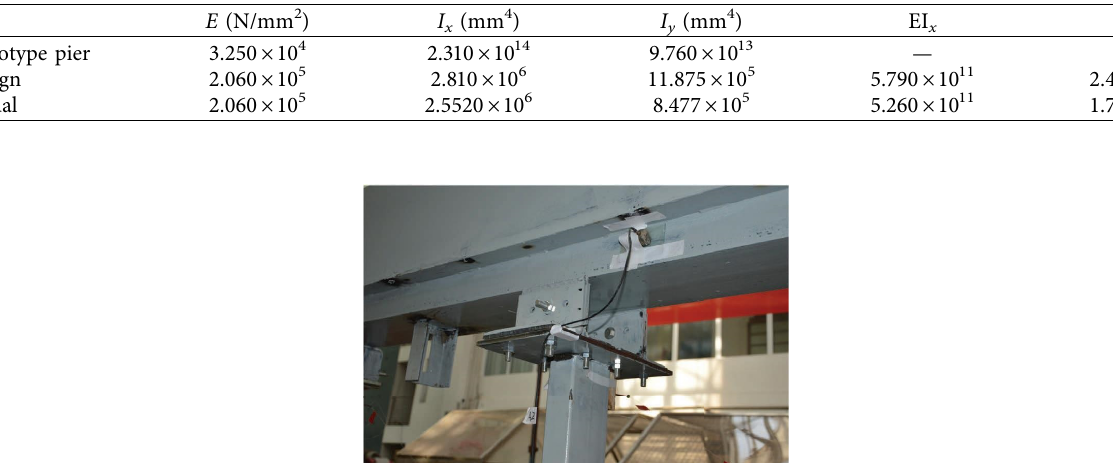
Table 2: Comparison of replacement parameters of pier material.